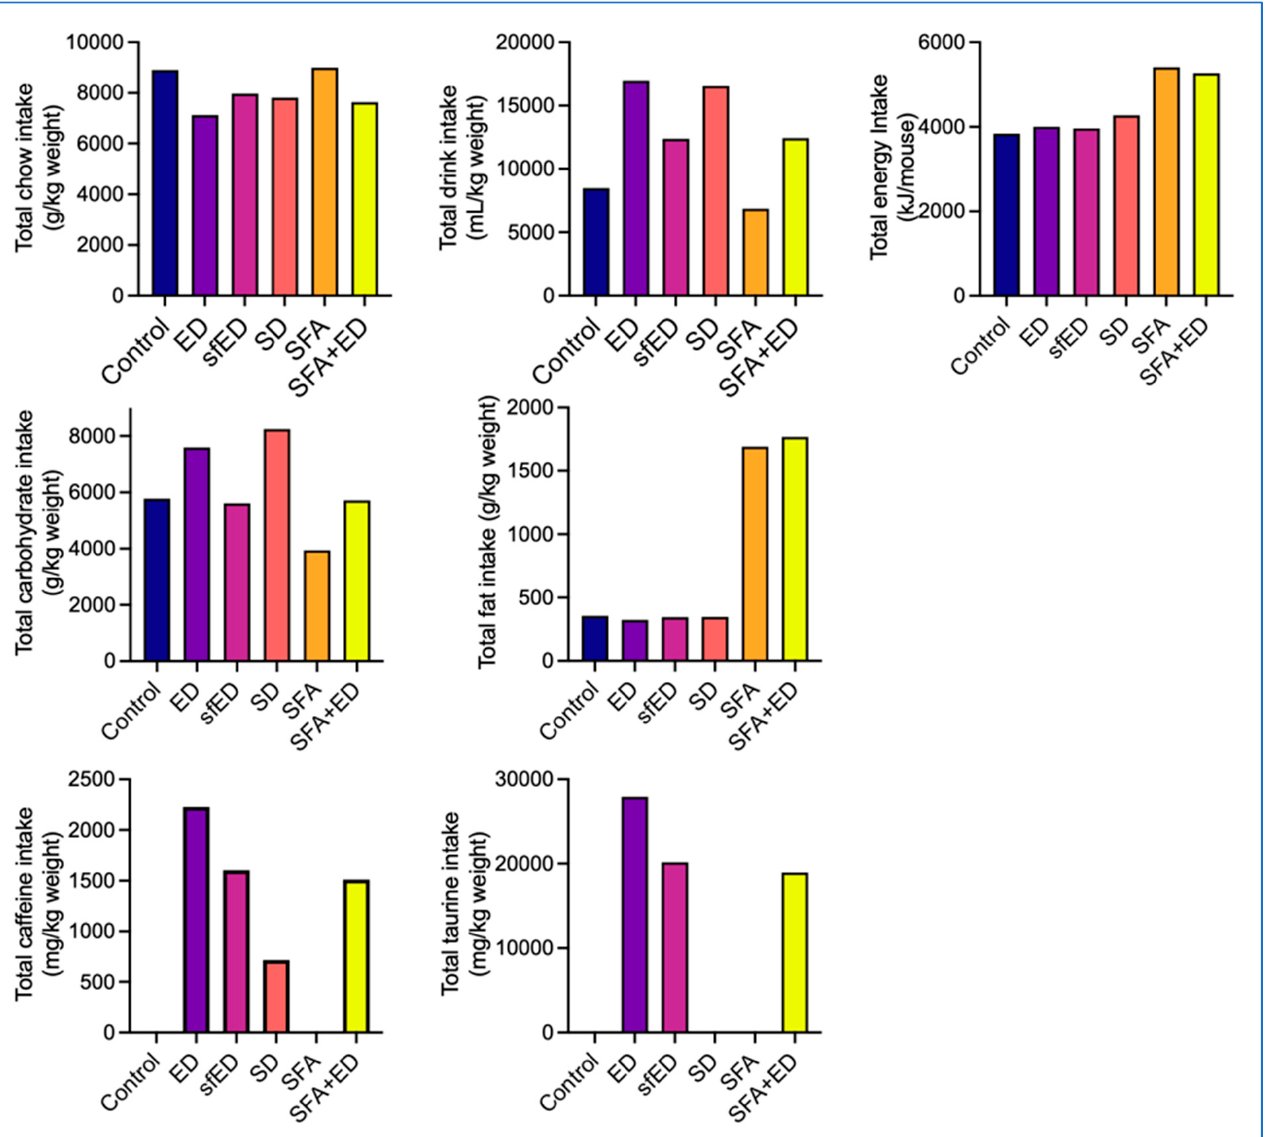
Figure 1. Chow, drink and nutrients consumption. The mice received no liquid intervention (control), Mother (ED), sugar-free Mother (sfED), Coca-Cola (SD), saturated fat enriched diet (SFA) or SFA with ED (SFA + ED) for 13 weeks. The chow and drink consumption was recorded twice weekly, and the total consumption over the 13-week experimental period is presented as per mouse. Statistical analyses were unable to be run because the data does not give errors.